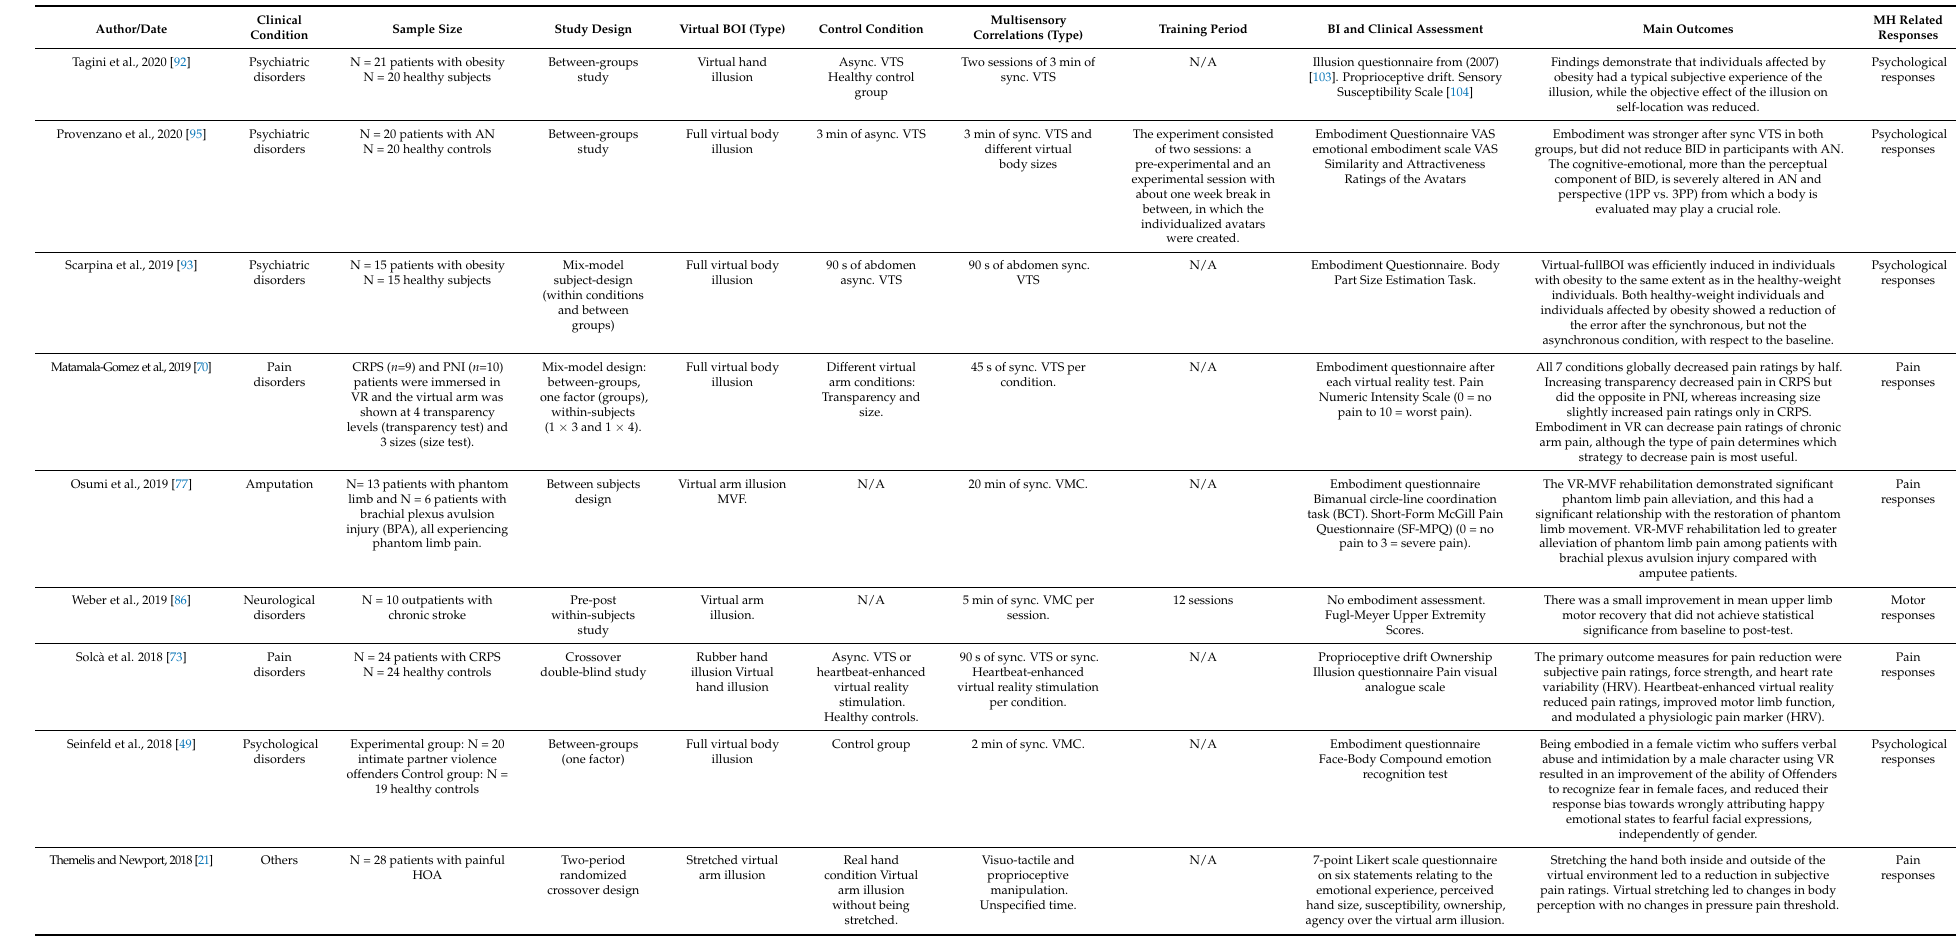
Table 1. Characteristics of the reviewed